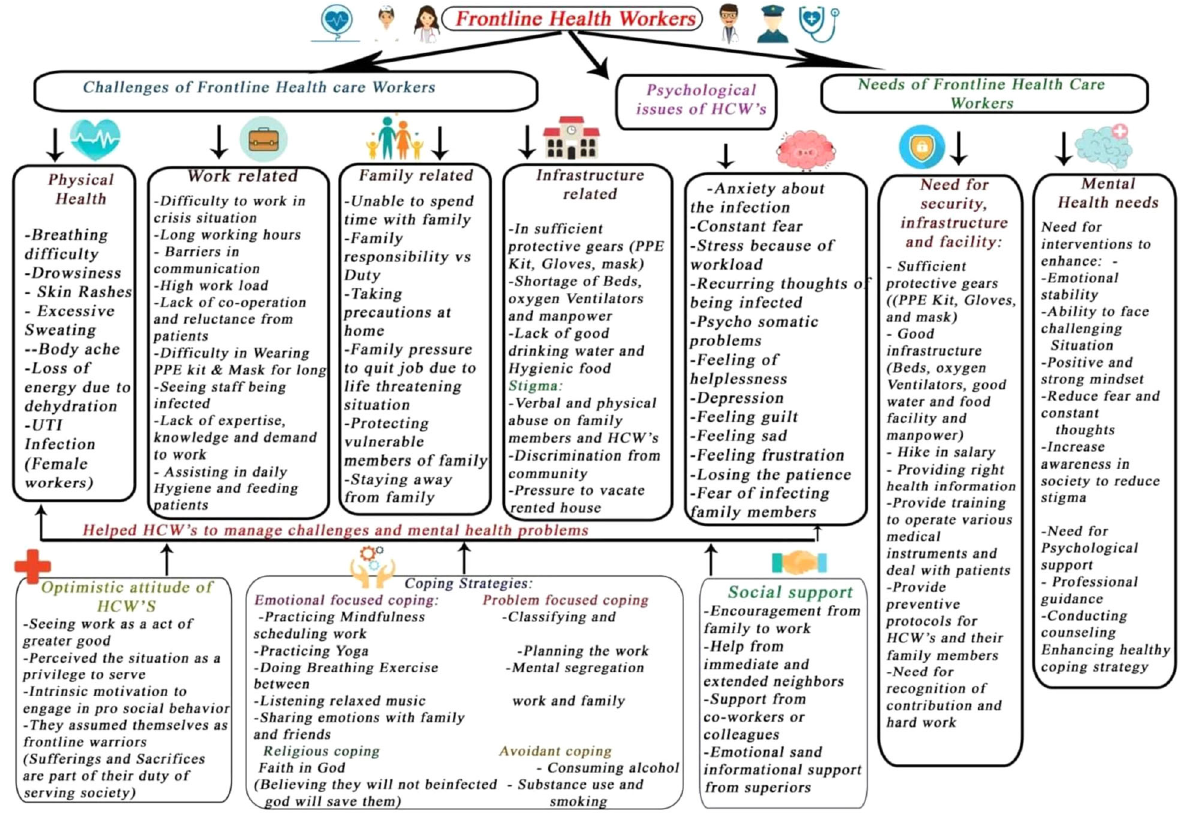
Fig. 1 Framework of summary of fi ndings. The challenges, psychological issues, needs and coping strategies used by frontline healthcare workers working in government